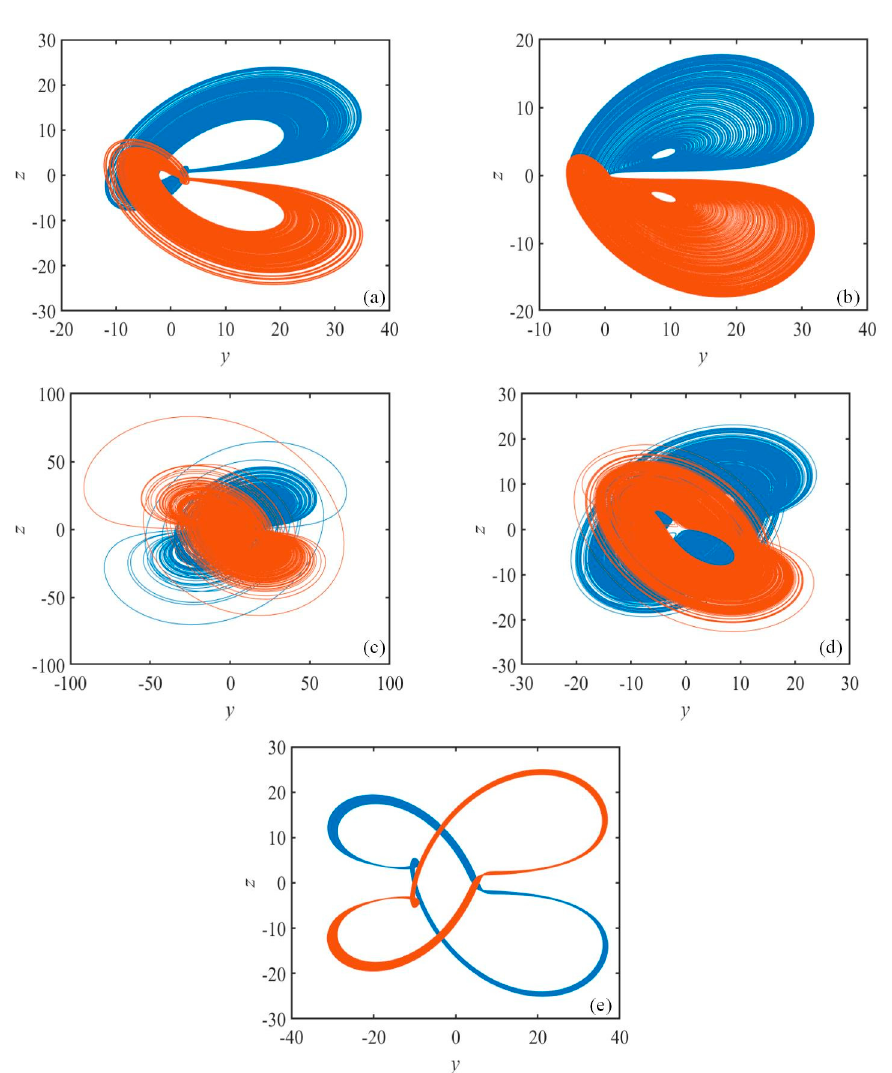
Figure 7. Y-Z plane with b =0.01, e =5, k =7, g =0.05, l =6: ( a ) a =3, c =7, d =31, when the initial conditions (1, 1, 1, 1, 1, 1) ( blue ) and (1, 1, 1, 1, 1, 1) ( red ) ; ( b ) a =3, c =2.4 , d =31, when the initial conditions (1, 1, 1, 1, 1, 1) (blue) and (1, 1, 1, 1, 1, 1) (red); ( c ) a =3, c =12, d =31, when the initial conditions (1, 1, 1, 1, 1, 1) (blue) and (1, 1, 1, 1, 1, 1) (red); ( d ) a =3, c =7, d =11, when the initial conditions (1, 1, 1, 1, 1, 1) (blue) and (1, 1, 1, 1, 1, 1) (red); ( e ) a =8.24, c =7, d =31, when the initial conditions (1, 1, 1, 1, 1, 1) ( blue ) and (1, 1, 1, 1, 1, 1) ( red ).